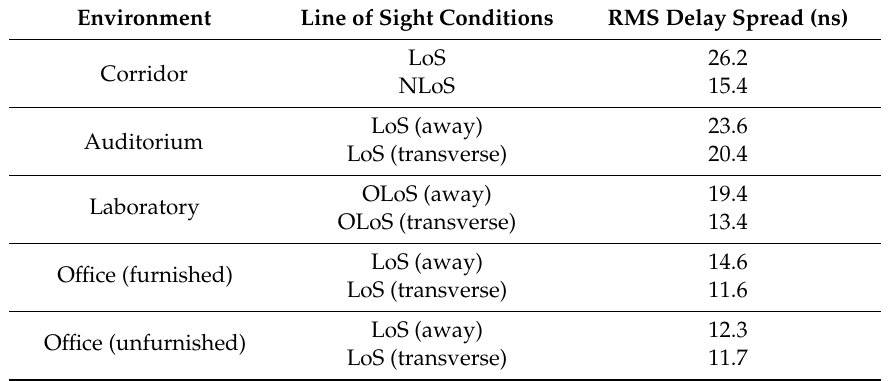
Table 2. Measured root mean square (RMS) delay spread (ns), for which 90% of cases are lower. Environment